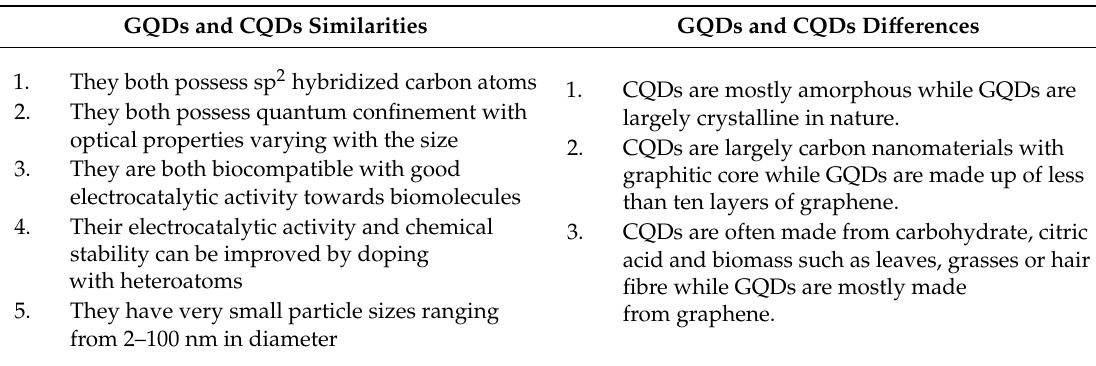
Table 1. Similarities and di ff erences between GQDs and